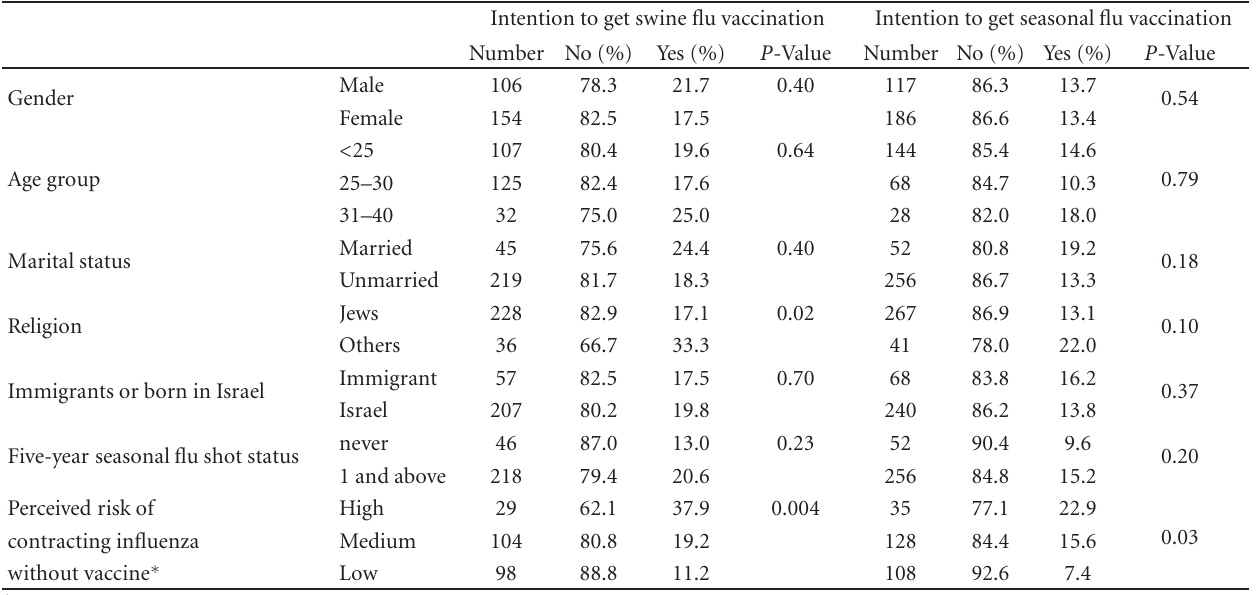
Table 2: Comparison of sample characteristics: Intention to get the swine flu vaccination versus intention to get the seasonal flu vaccination. Intention to get swine flu